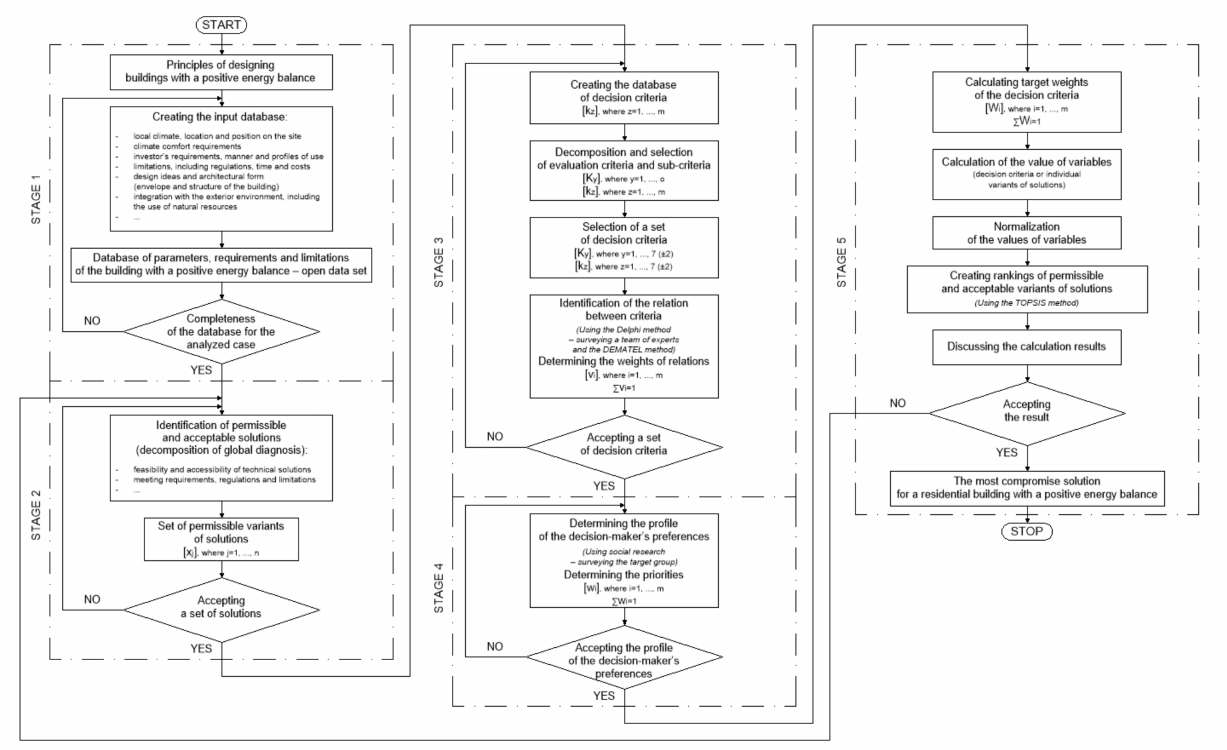
Figure 1. Methodology for designing a residential building with a positive energy